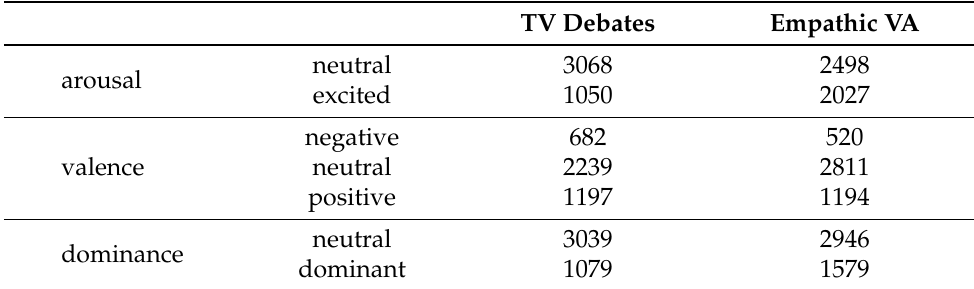
Table 7. Final categories for each dimension of the VAD model with the number of samples they contain in each of the